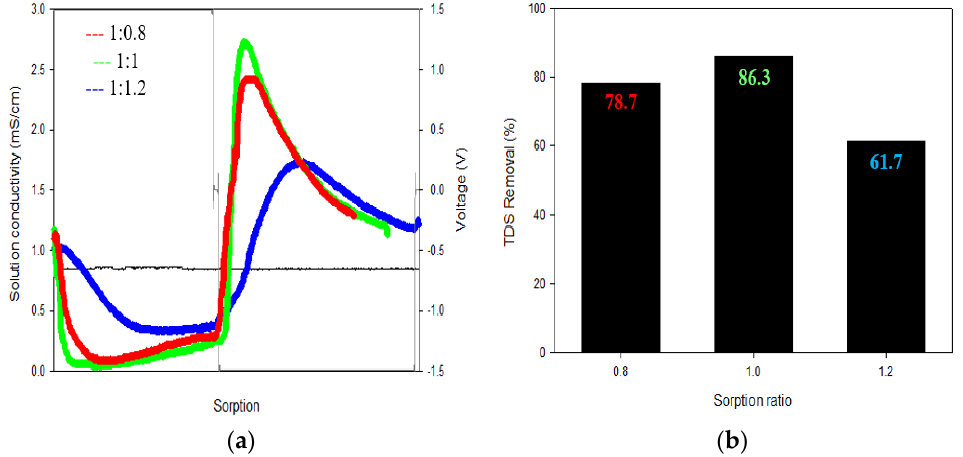
Figure 6. The results of the sorption ratio (adsorption/desorption) of the CDI: ( a ) Sorption ratio was set at 1:0.8, 1:1 and 1:1.2; ( b ) The TDS removal rate was the highest at 86.3% at